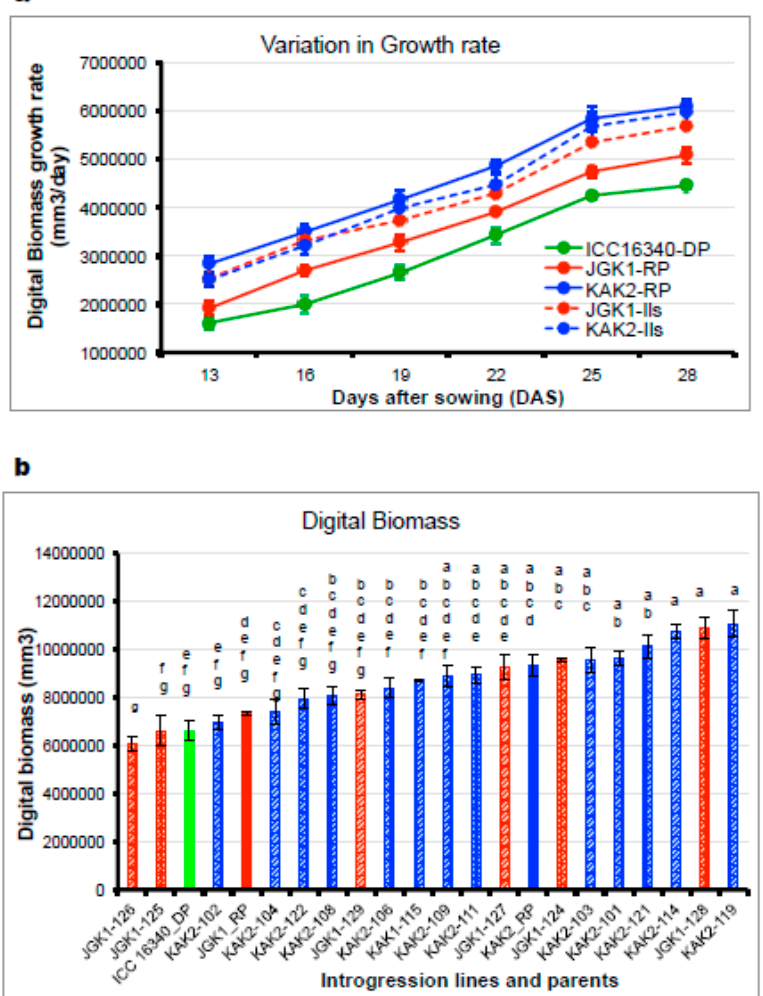
Figure 7. ( a ) Growth rate variation in digital biomass of stay green chickpea introgression lines (ILs) with di ff erent genetic background [stay green donor parent (DP) ICC 16,340 (round with solid green line); Recurrent parent (RP) JGK1 (round with solid red line); JGK1 background introgression lines JGK1-ILs (round with dashed red line); Recurrent parent (RP) KAK2 (round with solid blue line); KAK2 background introgression lines KAK2-ILs (round with dashed blue line)] are measured by LeasyScan phenotyping platform. Each data point represents the means ( ± SE) of four replicates per genotype. Data were used to draw a line graph for all tested genotypes. ( b ) Variation in digital biomass of stay green chickpea introgression lines (ILs) with di ff erent genetic background [stay green donor parent (DP) ICC 16,340 (bar filled with solid green colour); Recurrent parent (RP) JGK1 (bar filled with solid red colour); JGK1 background introgression lines JGK1-ILs (bar crossed lines with red colour); Recurrent parent (RP) KAK2 (bar filled with solid blue colour); KAK2 background introgression lines KAK2-ILs (bar crossed lines with blue colour)] are measured by LeasyScan phenotyping platform. Each data points represents the means ( ± SE) of four replicates per genotype. Data were used to draw a bar graph for all tested genotypes. Bars with di ff erent letters are significantly di ff erent ( p < 0.05).